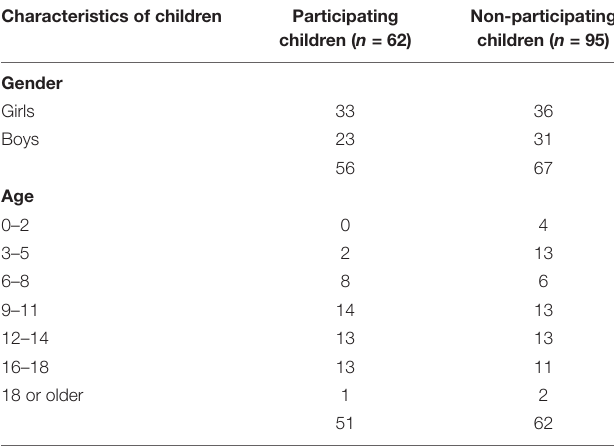
Information missing about gender for participating 6 participating and 28 non- participating children, and information missing about age for 11 participating children and 33 non-participating children.